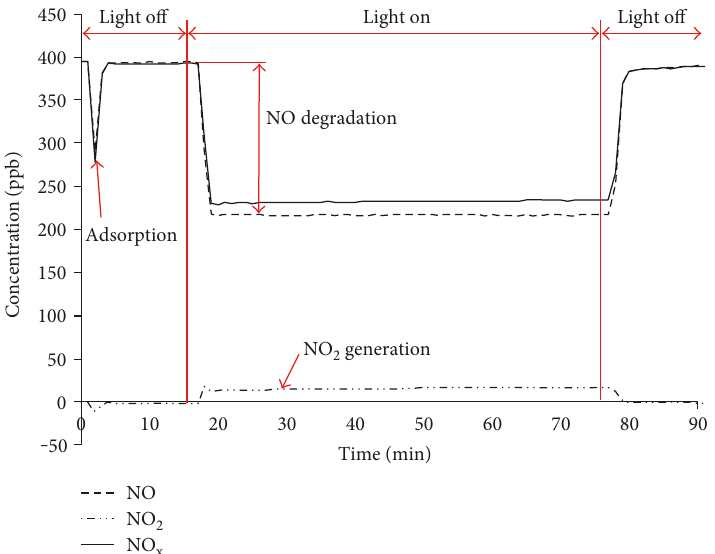
Figure 8: Typical evolution of NO, NO light at 1W/m 2 with a TiO